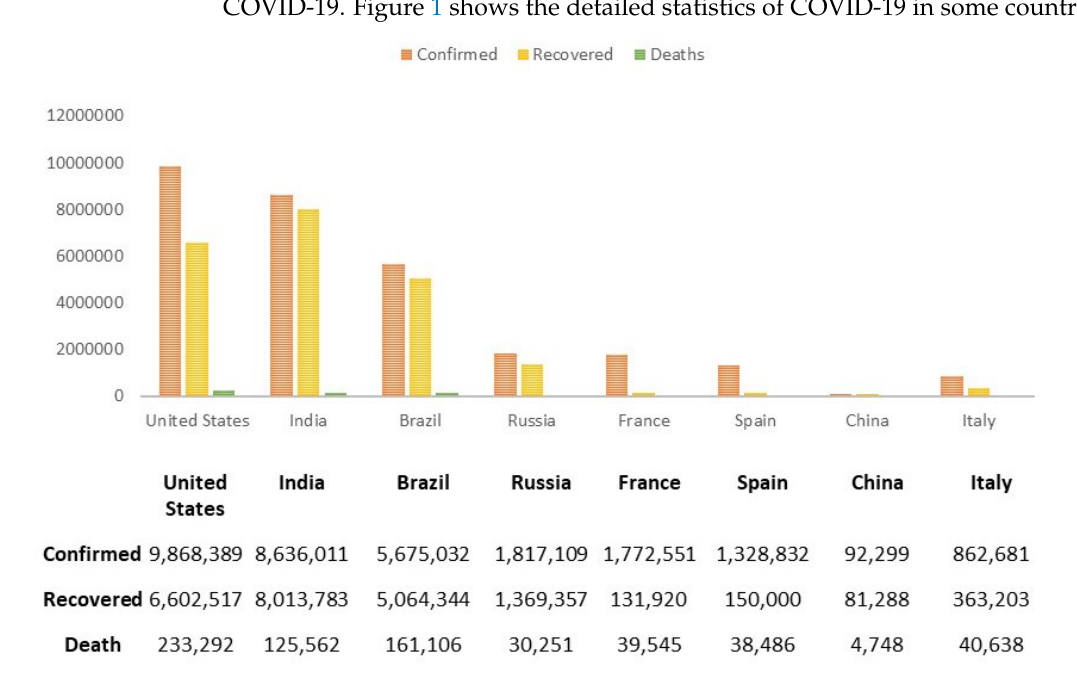
Figure 1. Statistics of confirmed, recovered and death cases of COVID-19 in some countries until 11th November